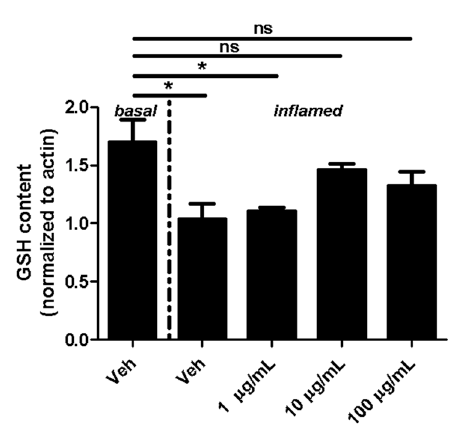
Figure 3. Effect of fullerenols on the glutathione (GSH) content. Quantification of GSH content (normalized to β -Actin; assessed by densitometric quantification of Western blot band intensity) in MBMEC after exposure to interferon- γ and tumor necrosis factor- α (inflamed; I + T; 100 IU each) and treatment with fullerenol (F; 1, 10 and 100 µg/mL; n = 3) for 18 h compared to cultures under basal (homeostatic milieu) conditions . Veh, vehicle treatment. * p < 0.05; ns, not significant.